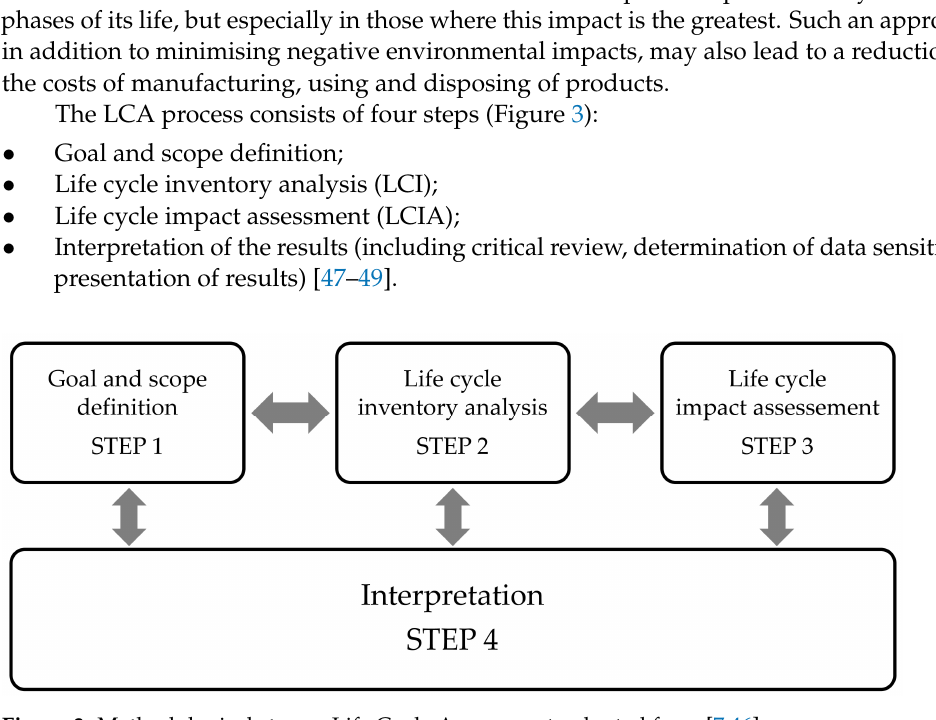
Figure 3. Methodological steps—Life Cycle Assessment, adapted from [7,46].